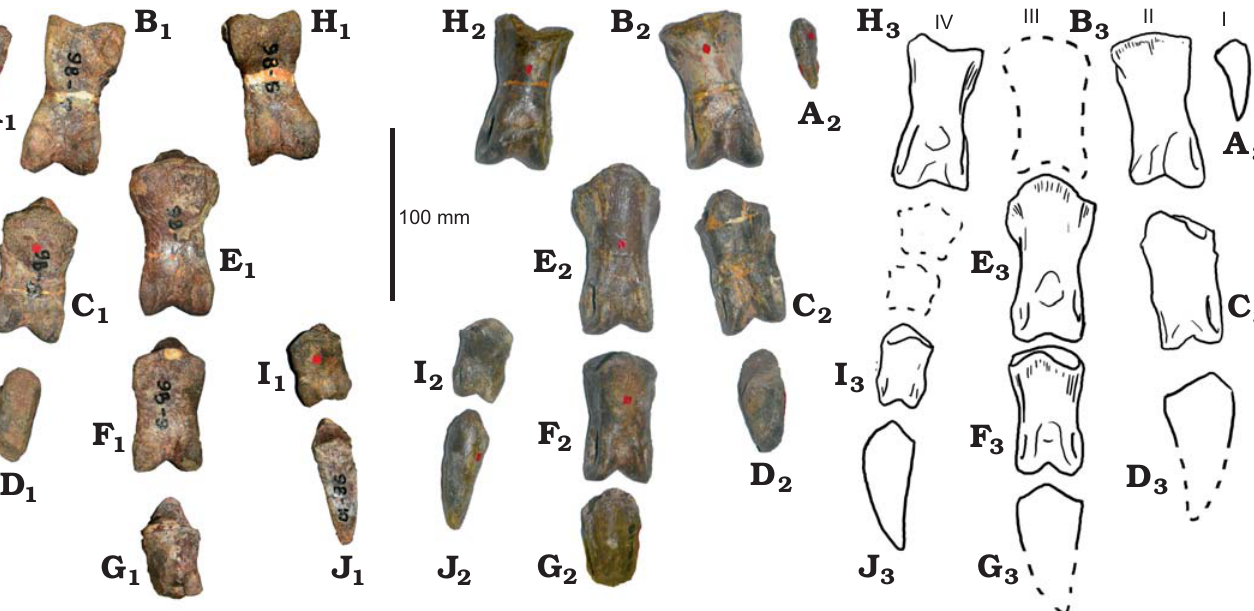
Fig. 13. Coelurosaurian theropod Phuwiangvenator yaemniyomi gen. et sp. nov. from the Early Cretaceous Sao Khua Formation of Phu Wiang, Khon Kaen Province, Thailand. SM-PW9B-11 ( A ), SM-PW9B-7 ( B ), SM-PW9B-8 ( C ), SM-PW9B-22 ( D ), SM-PW9B-5 ( E ), SM-PW9B-9 ( F ), SM-PW9B-19 ( G ), SM-PW9B-6 ( H ), SM-PW9B-45 ( I ), SM-PW9B-10 ( J ); right pedal phalanges (B, C, E, F, H, I) and unguals (A, D, G, J), in ventral (A 1 –J 1 ) and dorsal (A 2 –J 2 ) views; line drawings in dorsal view (A 3 –J 3 ). Dashed lines are the reconstruction of pedal phalanges III-1, IV-2, and IV-3 and pedal unguals II-3 and III-4.